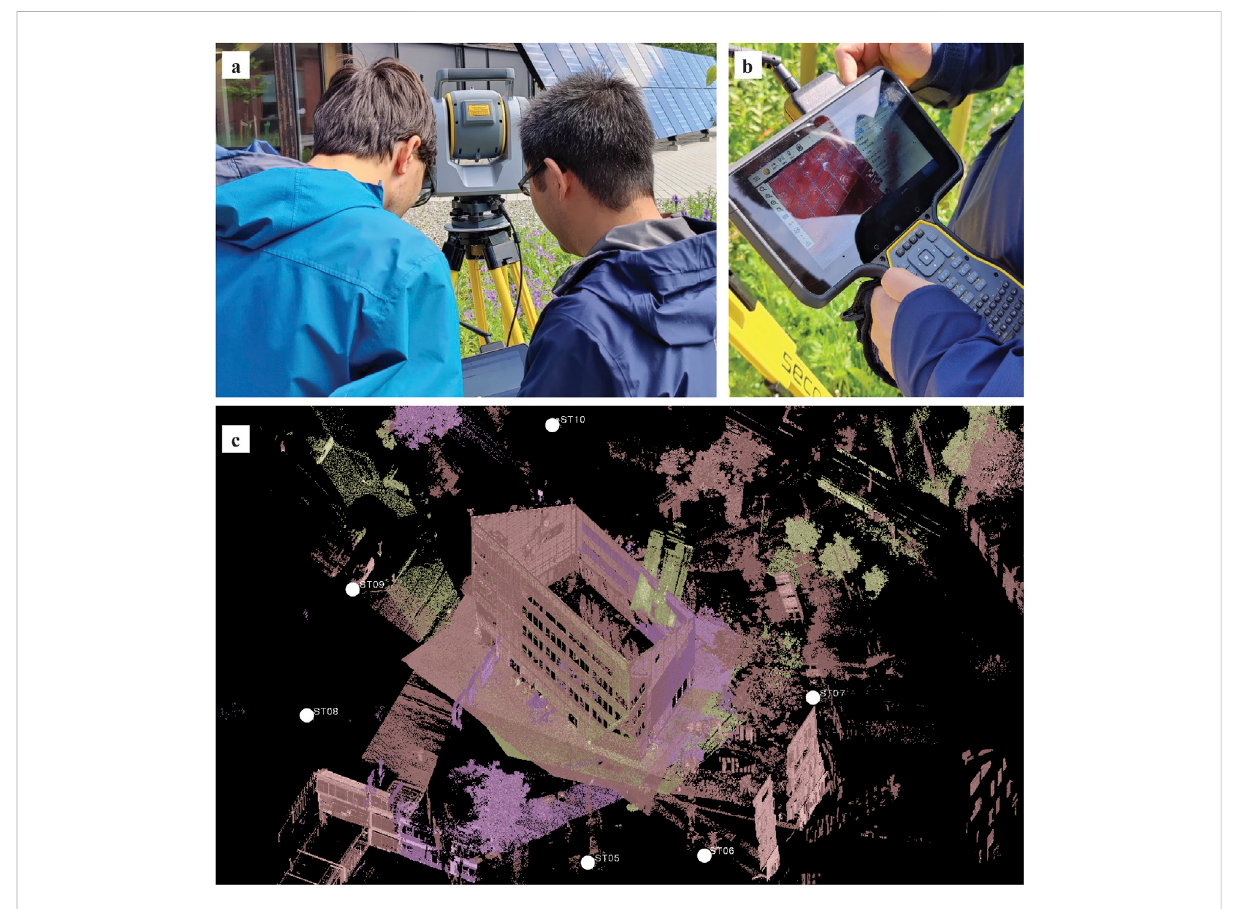
FIGURE 5 Fromthetop: (A) scanningoperations, (B) viewofthepointcloudduringthescanningoperations,and (C) positionsofscanningstationsaround the ZEB